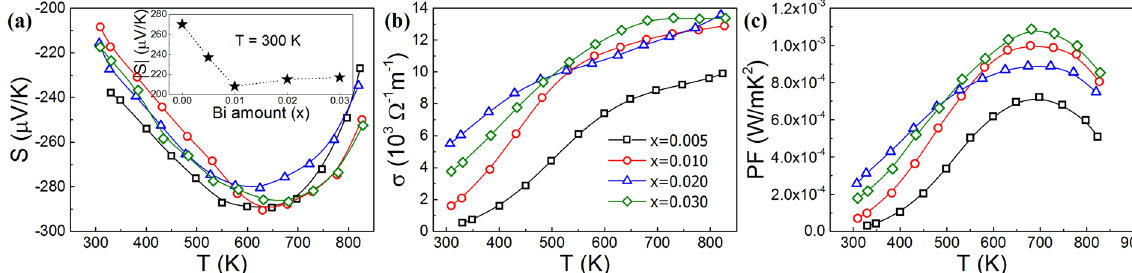
Figure 2. Temperature dependence of ( a ) the Seebeck coefficient, inset: room temperature Seebeck coefficient as a function of the added Bi; ( b ) the electrical conductivity, and ( c ) the power factor of the Mg 2 Ge 1 − x Bi x ( x = 0.005, 0.010, 0.020, 0.030) samples.